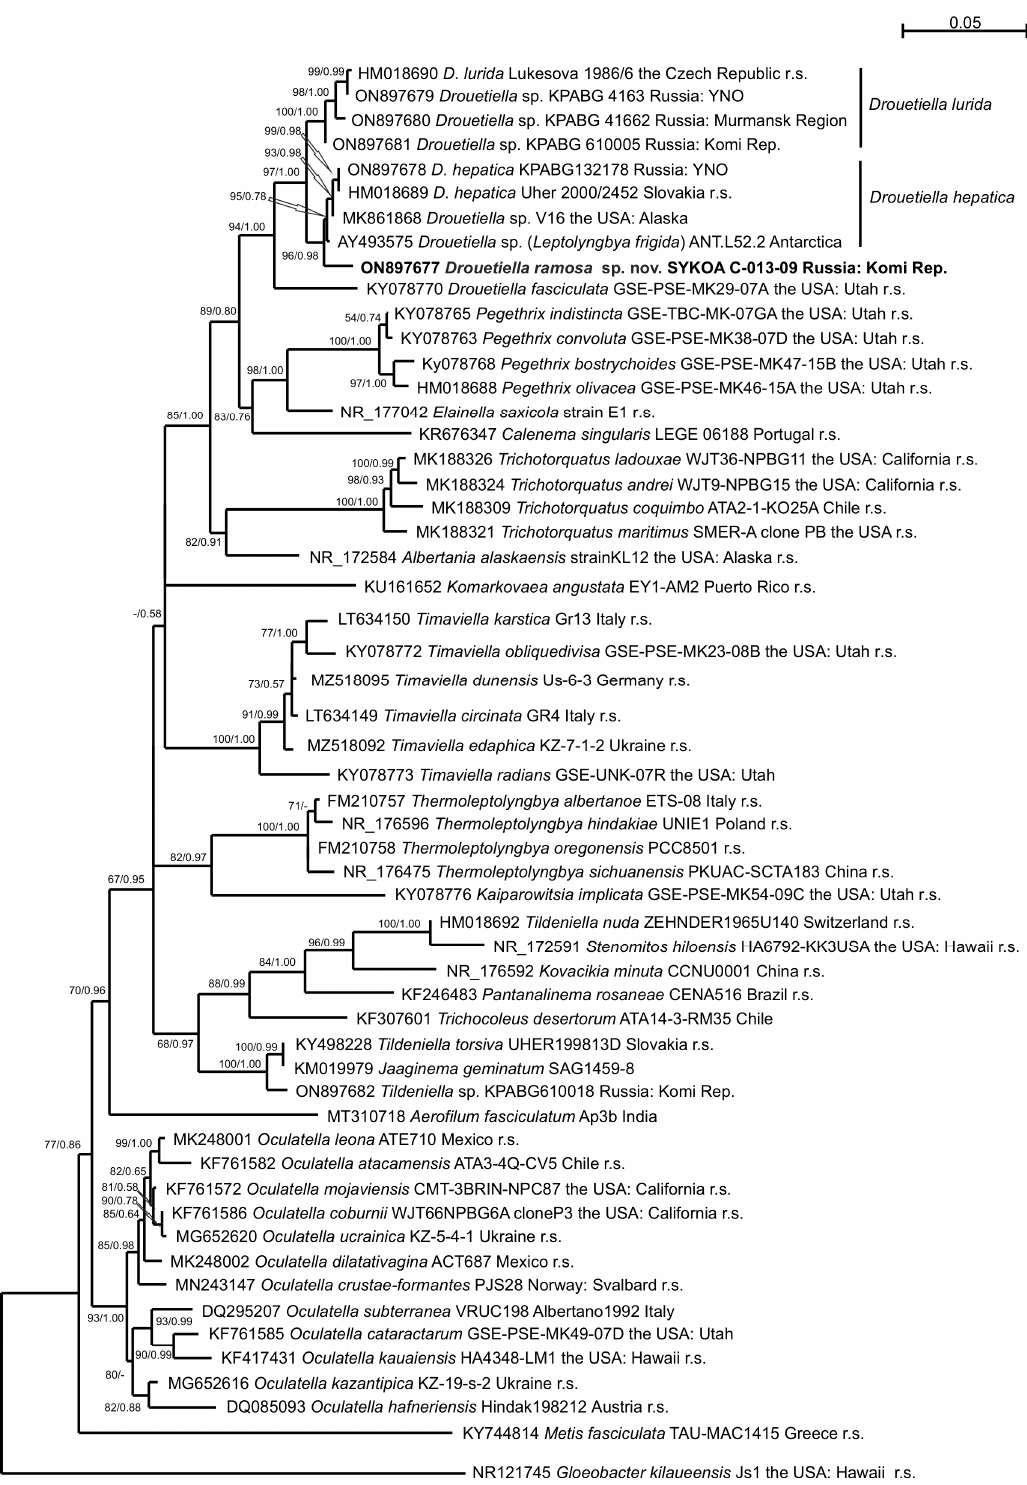
Figure 4. Phylogram obtained under the maximum likelihood approach for 56 accessions of Oculatellaceae based on the 16S rRNA gene. Bootstrap support values from the maximum likelihood and Bayesian posterior probabilities more than 50% (0.50) are indicated. The reference strain marked as r.s.; YNO: Yamalo-Nenets A.O.